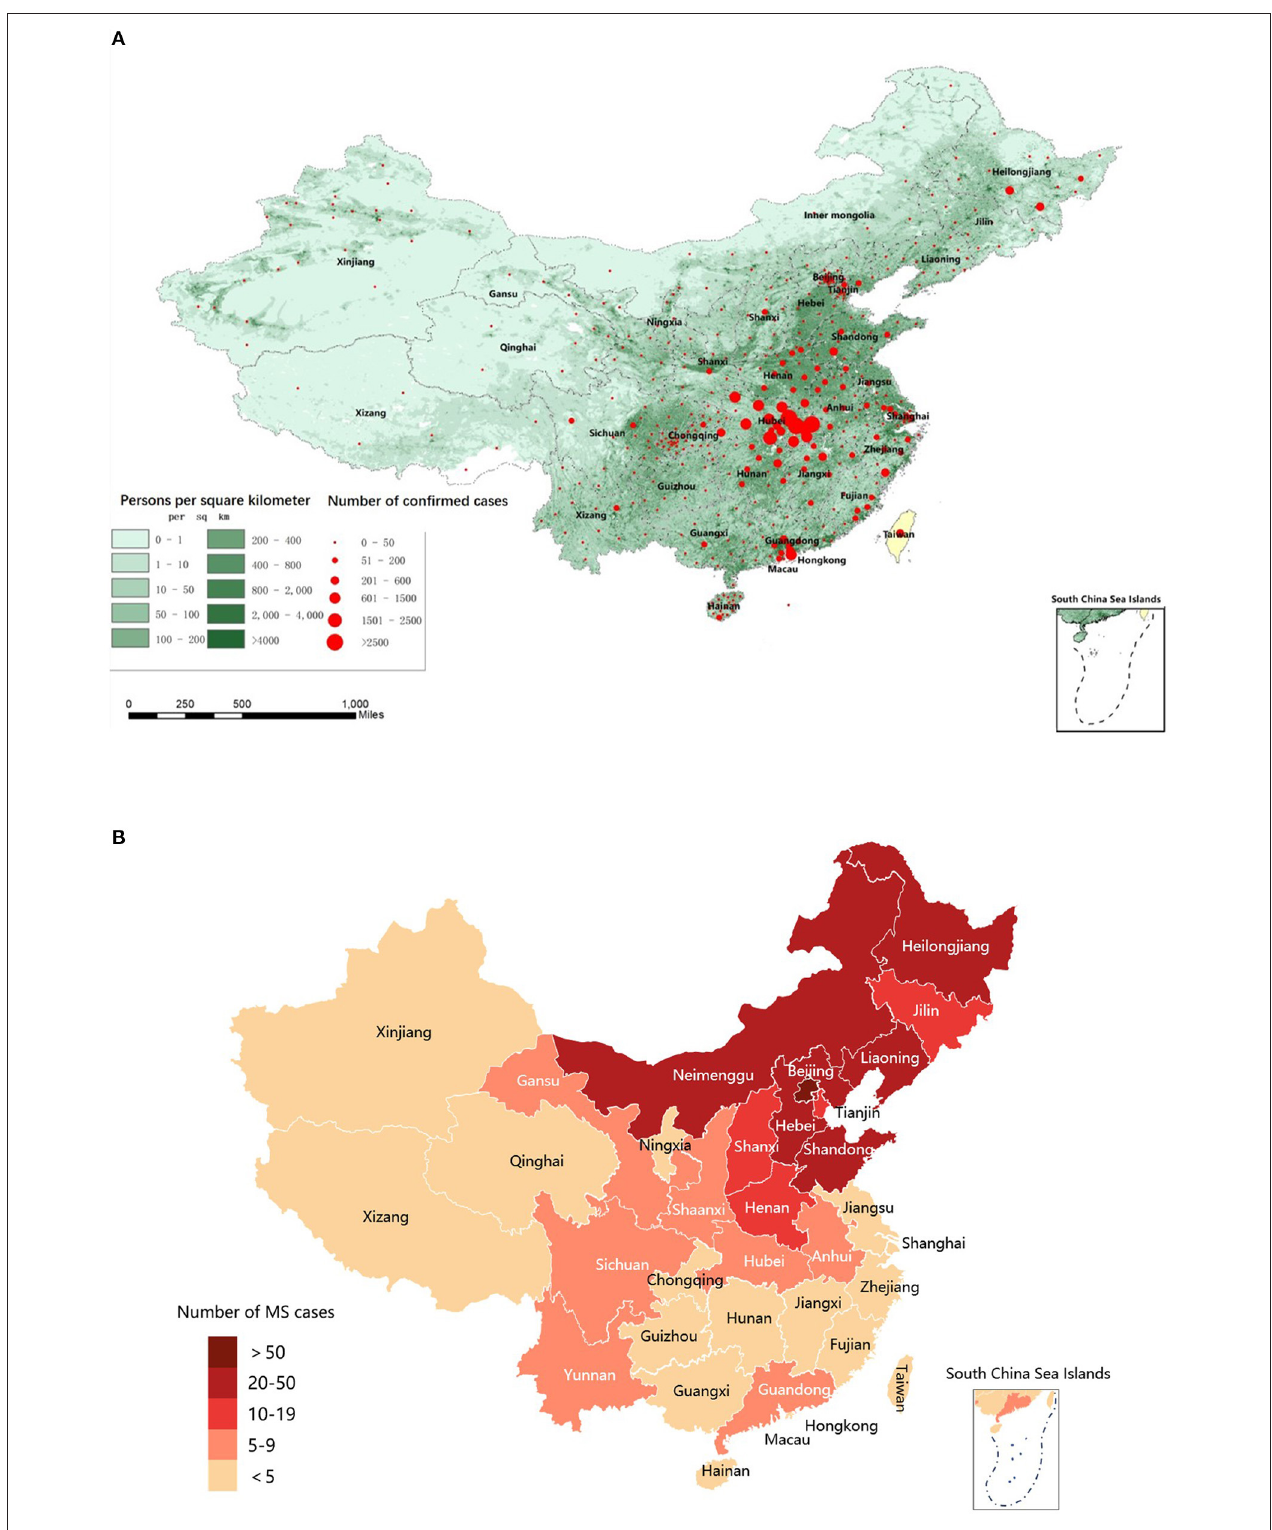
FIGURE 1 | Distribution map of confirmed COVID-19 cases across China, population density in mainland China, and MS patients in the MS/NMO database. (A) Population density of China and distribution map of confirmed COVID-19 cases across China during the pandemic (From December 15, 2019, to June 1, 2020). (B) Distribution map of MS patients in the MSNMOBase across China. COVID-19, coronavirus disease 2019; MS, Multiple Sclerosis.